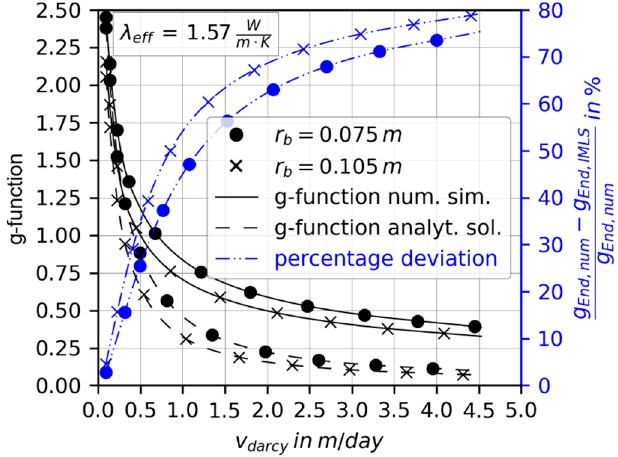
Figure 4. Deviation of the g-functions between the numerical model with a grouted borehole and the analytical infinite MLS model.